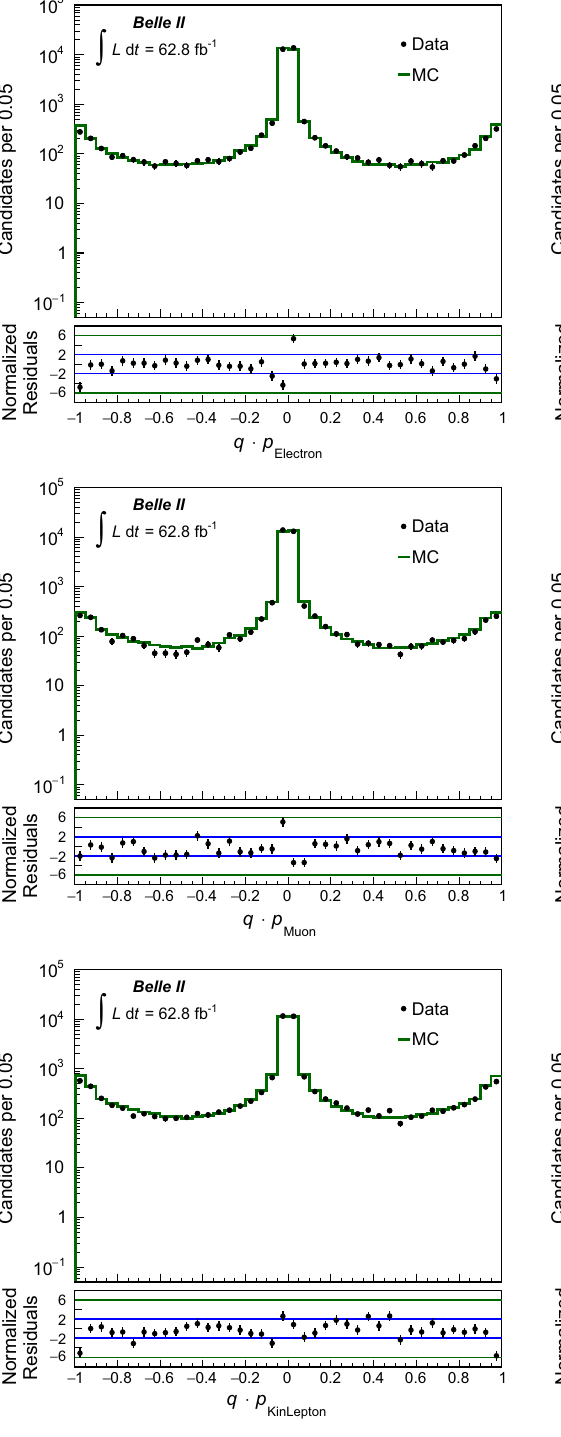
( ∗ ) − + B 0 → D h candidates. The contribution from the signal com- ponent in data is compared with correctly associated signal MC